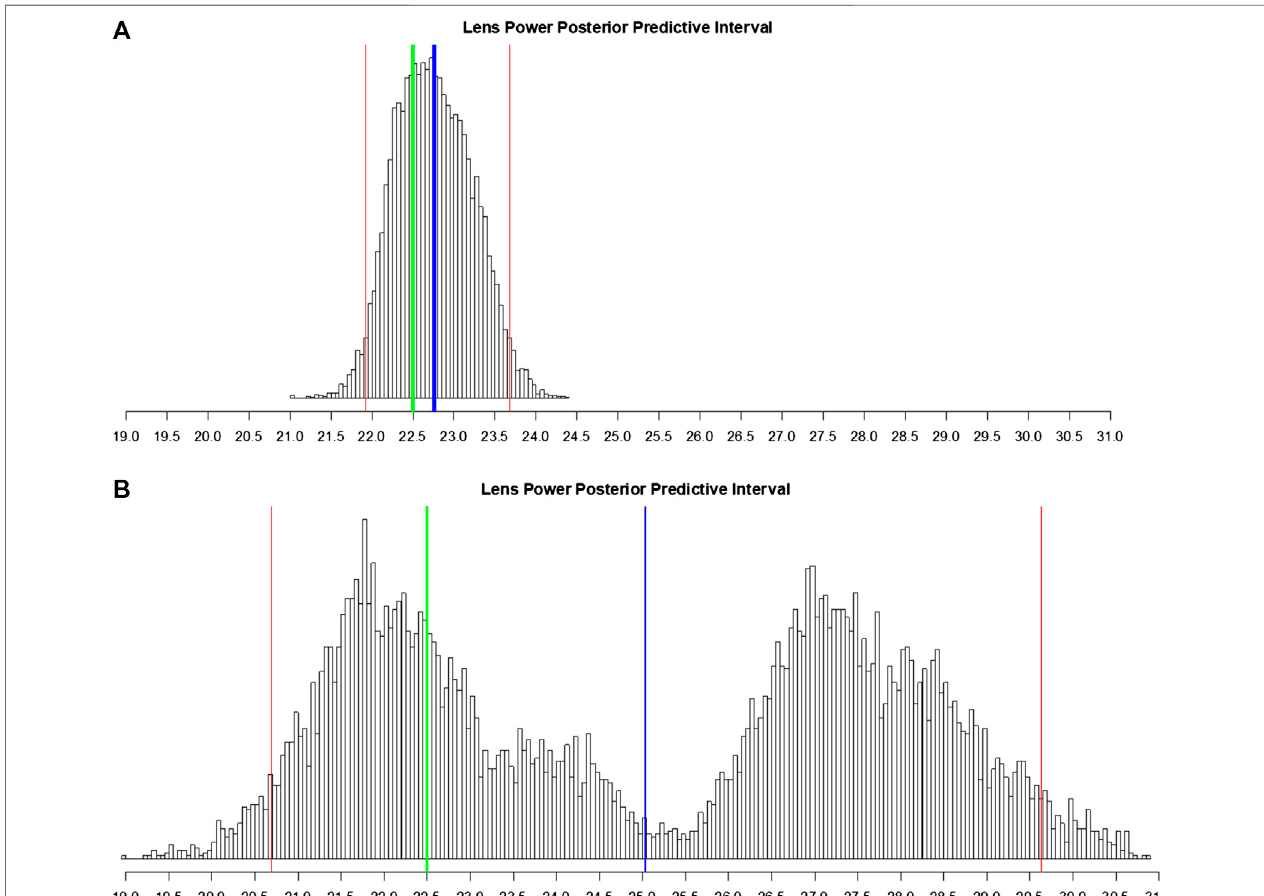
FIGURE5| Histogramofposteriorpredictivesamplesforarandomout-of-samplepatienteye.Thex-axishastheIOLvalues.TheblueverticallineindicatestheIOL prediction (mean of probabilities). The two red lines indicate the 95% predictive interval for IOL. The green line indicates the true lens power for this patient. (A) Posterior predictive sample for the eye with all measurements recorded. (B) Same as (A) except that many predictive variables were marked as missing.